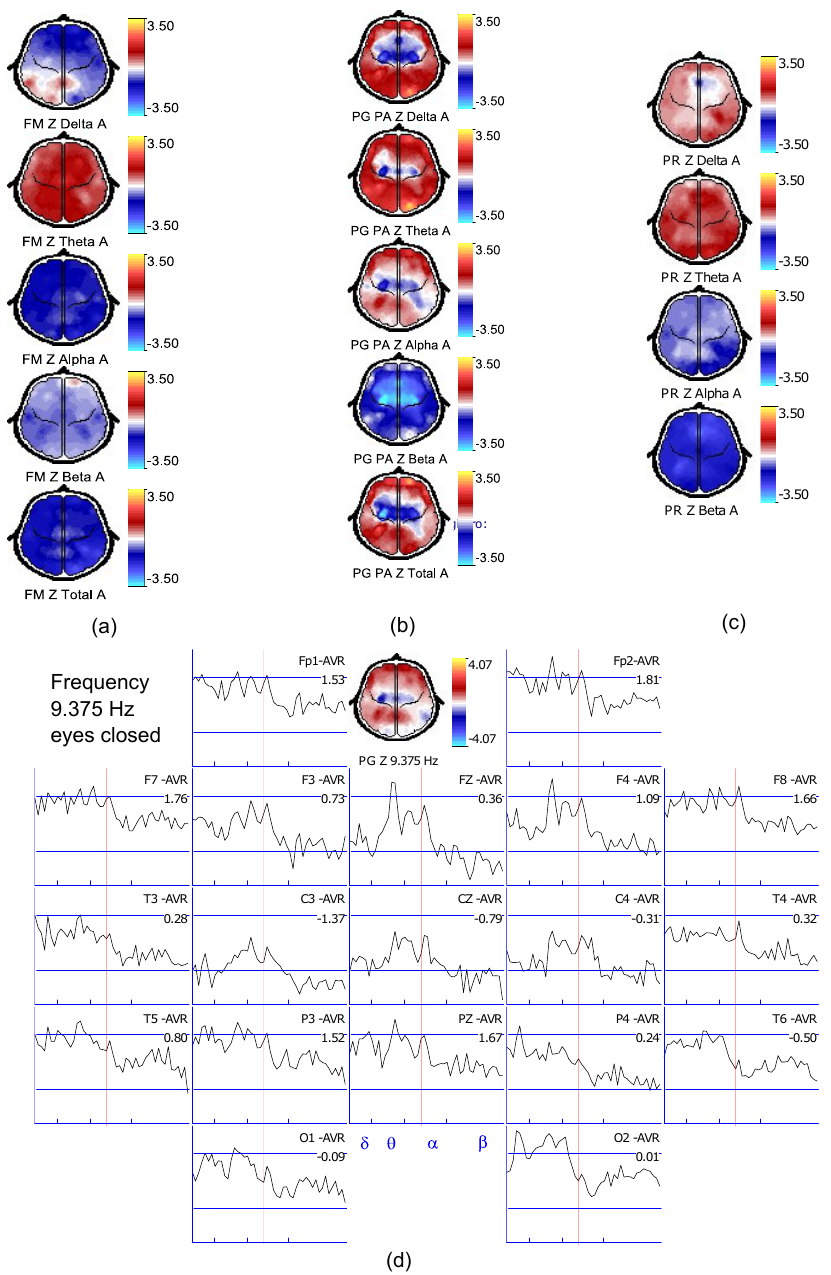
Figure 1. Images obtained from Neuronic software after the LTH program. ( a ) the mean frequency; ( b ) absolute power; ( c ) relative power; ( d ) FFT